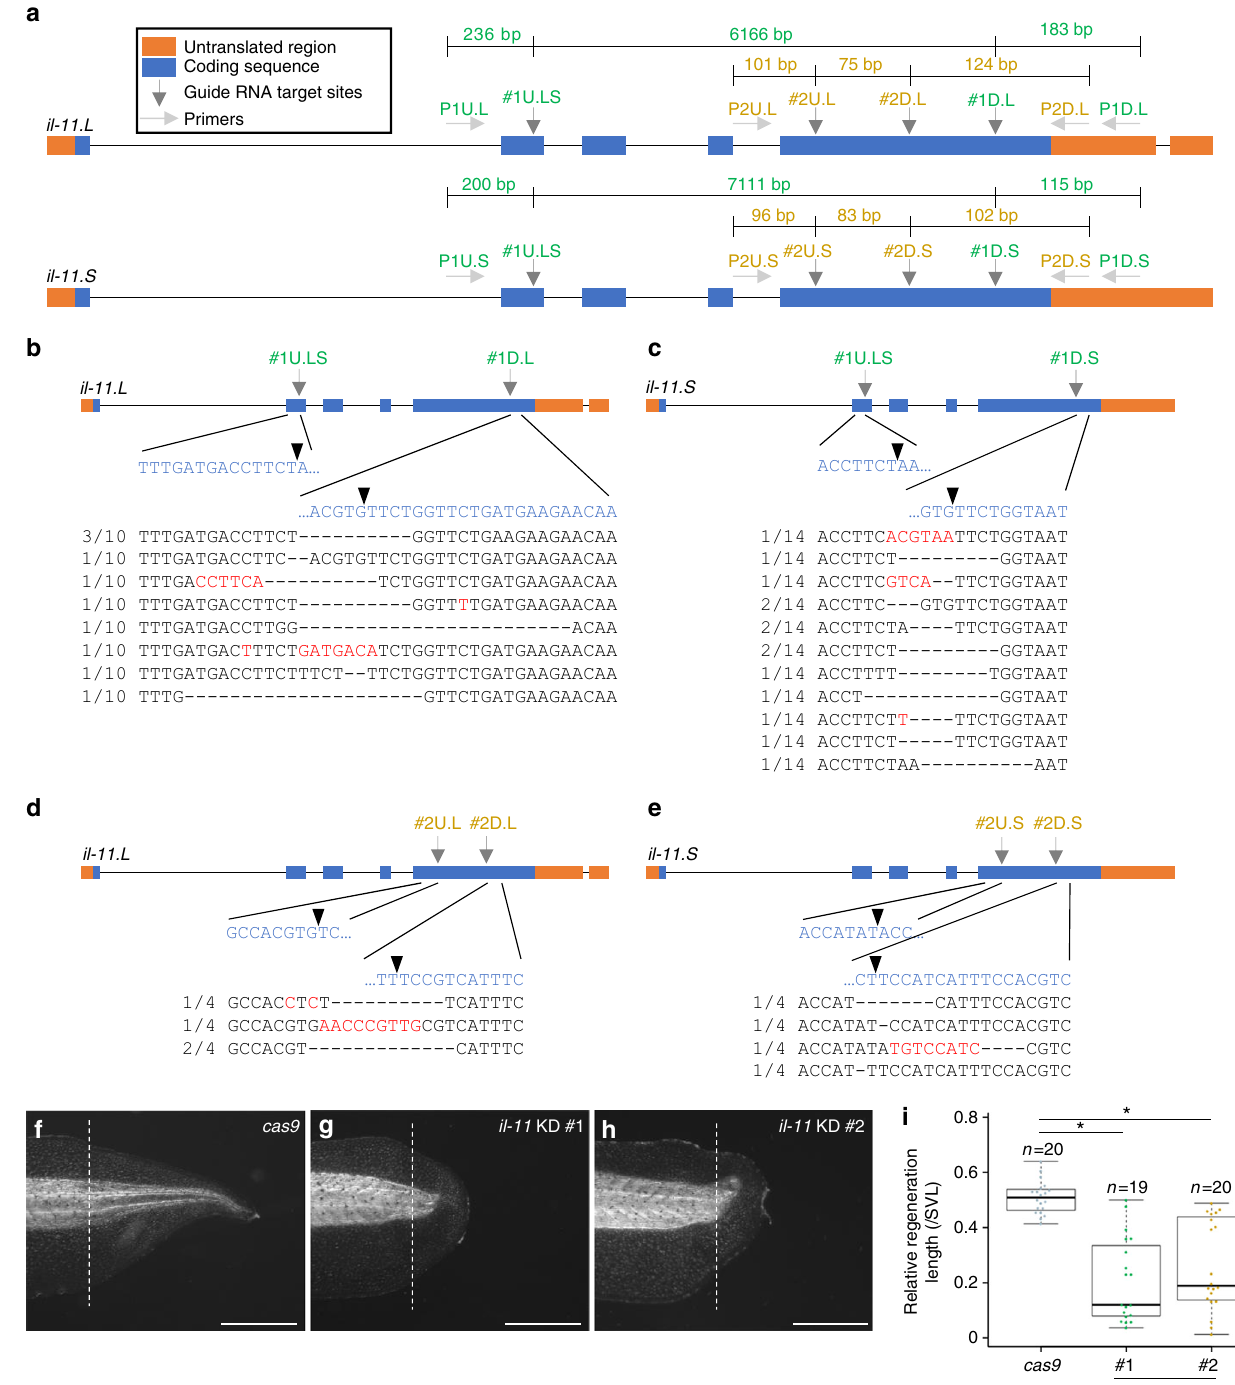
Fig. 2 Knockdown of il-11 in tadpoles. a Schematic drawing of genomic structure of il-11 . Bars: introns , orange boxes : untranslated regions, blue boxes : coding sequences, dark grey vertical arrows : gRNA target sequences, light grey horizontal arrows : primers. b – e , Genomic sequences of tadpoles injected with cas9 mRNA and gRNAs. Genomic DNA was extracted from all body of il-11 KD #1 tailbud embryos b , c or tail of il-11 KD #2 tadpoles d , e , and sequences corresponding to il-11.L b , d or il-11.S c , e were PCR-ampli fi ed using P1U.L/P1D.L b , P1U.S/P1D.S c , P2U.L/P2D.L d , or P2U.S/P2D.S e primers. The PCR product of the expected length corresponding to deletion of the region between two gRNA target sites was sequenced. Blue characters : reference genomic sequences nearby gRNA target sites, red characters : mismatches from reference genomic sequences, bars : gaps, arrowheads : predicted cleavage sites. Numbers at the left corner indicates ratio of clones containing the sequence to total clones sequenced. f – i , Representative images of tails of control cas9 mRNA-injected f , il-11 KD #1 g , or il-11 KD #2 h tadpoles at 7 dpa, and the tail regeneration length i are shown. Dark- fi eld images f – h are shown. Anterior is to the left , dorsal is up . White broken lines indicate amputated plane. Scale bars : 1 mm. Regeneration length was normalised by snout to vent length (SVL). Box plots are inserted in the panels. Bars in the boxes represent median, upper and lower limits of the boxes represent the fi rst and third quartiles, and whiskers represent maximum and minimum values. * P < 0.05, Dunnett ’ s